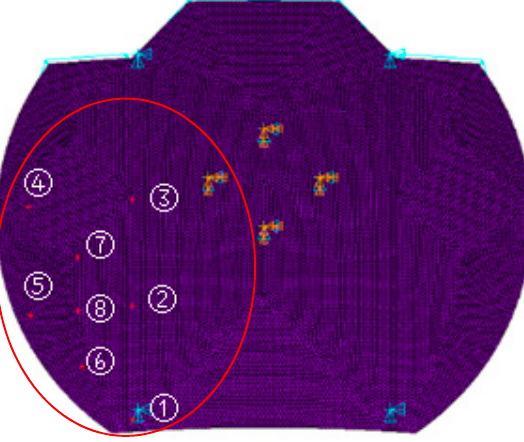
Figure 5. Forced simulation of the ANSYS model.